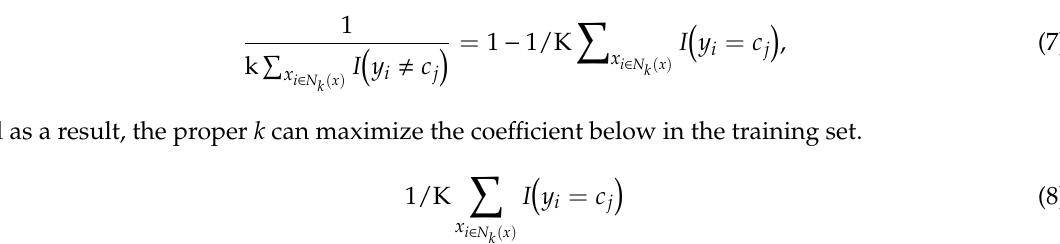
Figure 9. The k-nearest neighbors algorithm.